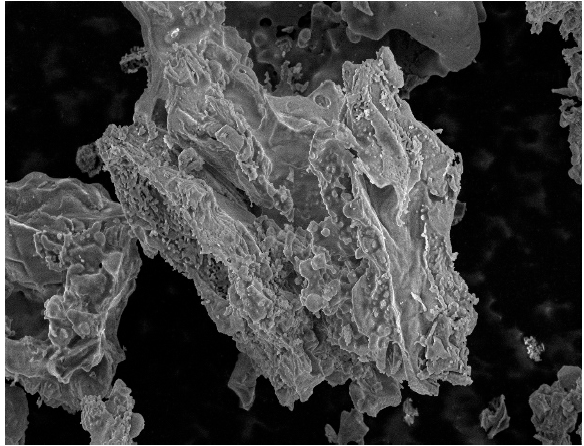
Figure 3. SEM diagram of RHA at 2000 times.